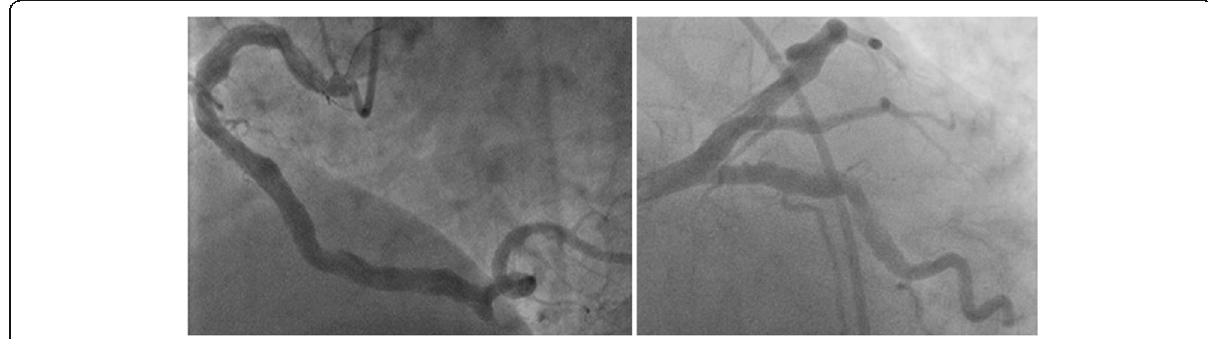
Fig. 2 Coronary angiography of one of our study population showing diffuse ectasia of RCA (left), and LAD and LCX